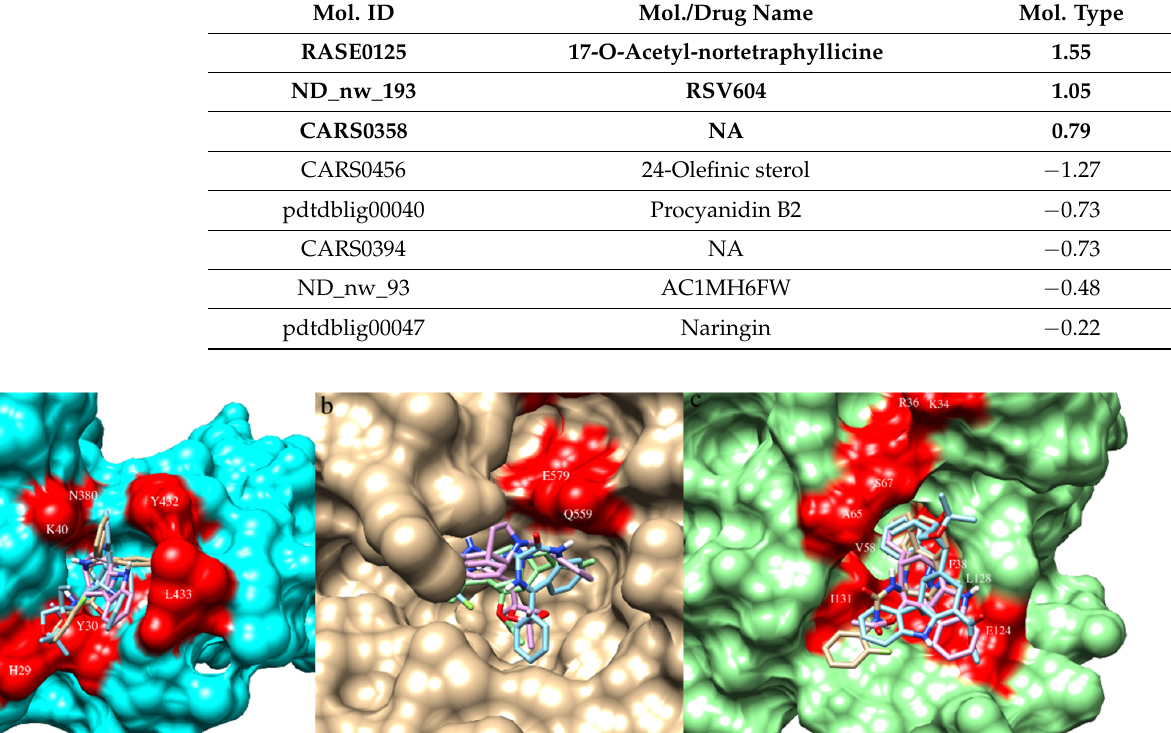
Figure 4. Molecule CARS0358 (blue), RASE0125 (pink), and ND_nw_193 (bisque) docked inside the respective ligand-binding sites (red colored) of NiV-F ( a ), NiV-G ( b ), and NiV-N ( c ) .